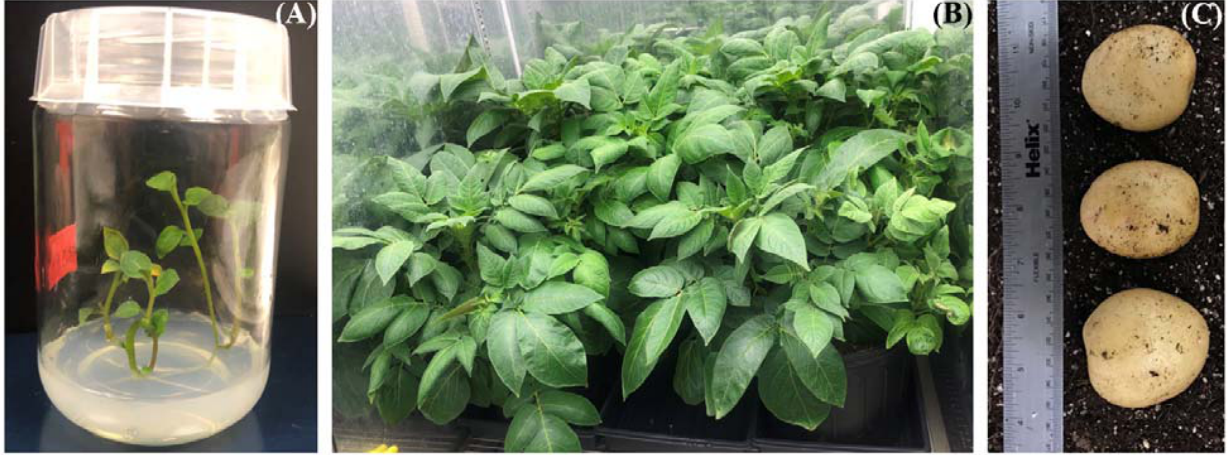
Figure 1. Regenerated, mutated Yukon Gold potato events. ( A ) Regenerated plantlets growing in vitro following nptII /Kanamycin-based selection. ( B ) Regenerated plants grown in soil in a growth chamber for tuber production. ( C ) Tubers collected two weeks after vine kill.